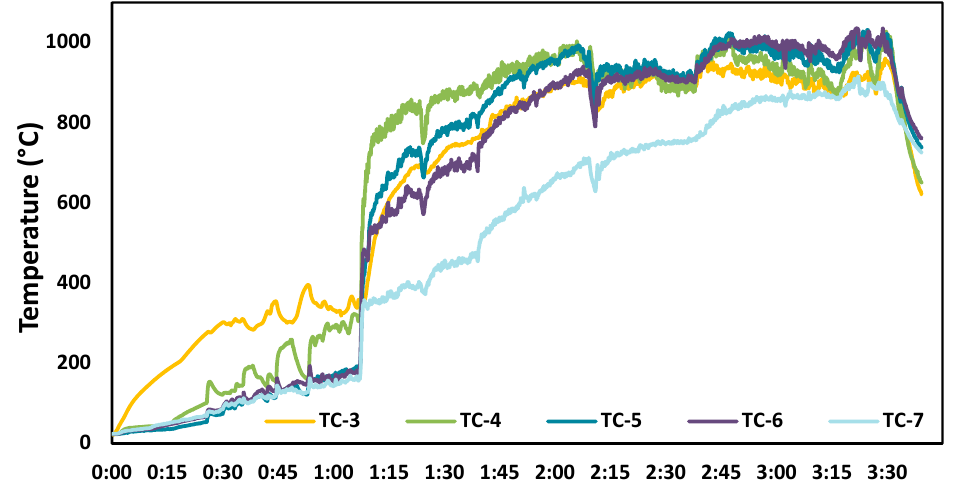
Figure 8. Thermal profile inside the gasification plant during the start-up (TC-3 (bed), TC-4 (fountain), TC-5 (middle 1), TC-6 (middle 2), and TC-3 (middle 3)).